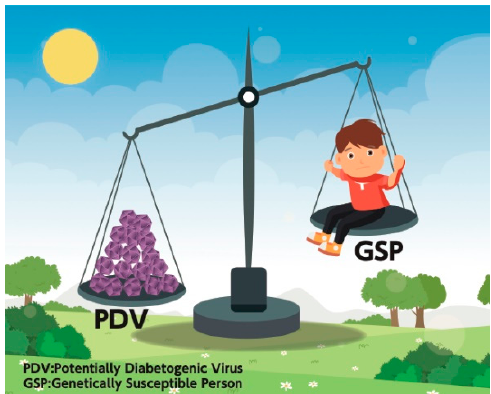
Figure 2. Balance between diabetogenicity of the virus and genetical susceptibility of the host. A potentially diabetogenic virus may cause diabetes in a genetically susceptible person. (The figure is derived from the front cover of the Journal of Medical Virology, August issue 2019 [134], following minor modification with permission from the publisher.)